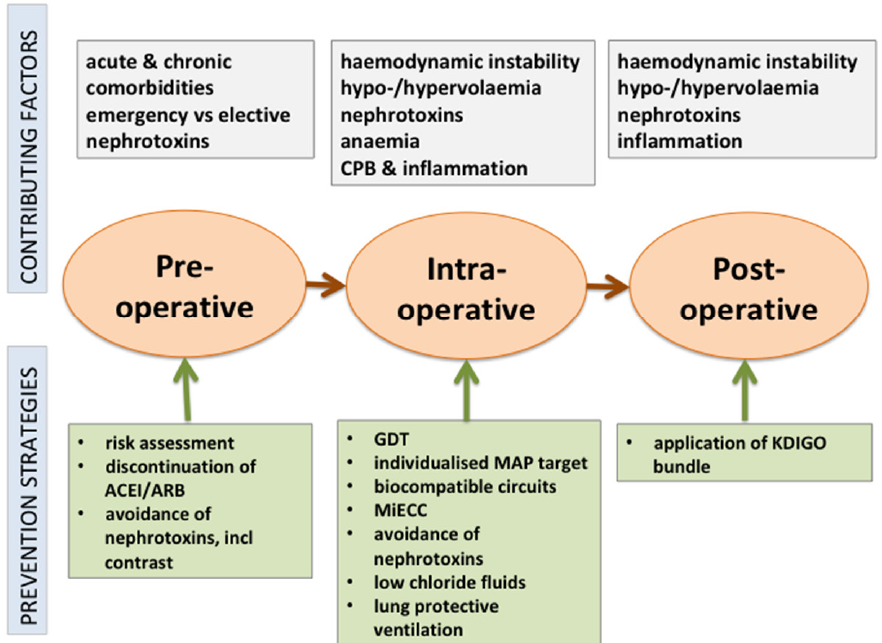
Figure 1. Perioperative strategies to prevent AKI after cardiac surgery.